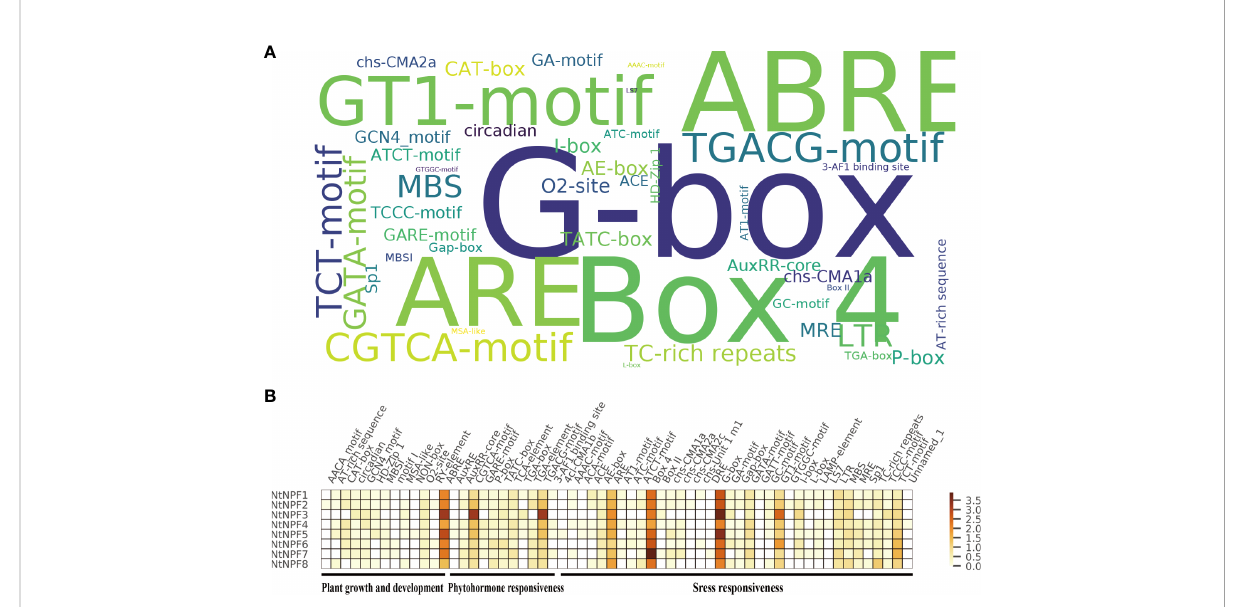
FIGURE 4 Cis -acting elements in the promoter of NtNPF genes of tobacco. (A) Over-presentation of the cis -acting elements in the promoter of all NtNPF genes. The font size is positively associated with the occurrence number of corresponding cis -acting elements. (B) Heatmap of average number of cis -acting elements in different NtNPF subfamilies. Brown represents a high number and white represents a low number of cis -acting